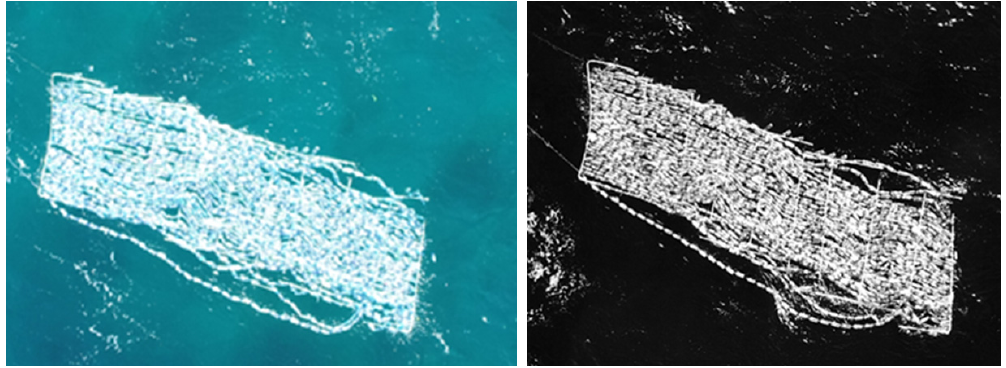
Figure 5. Left : RGB image of plastic litter target. Right : infrared image of plastic litter target.